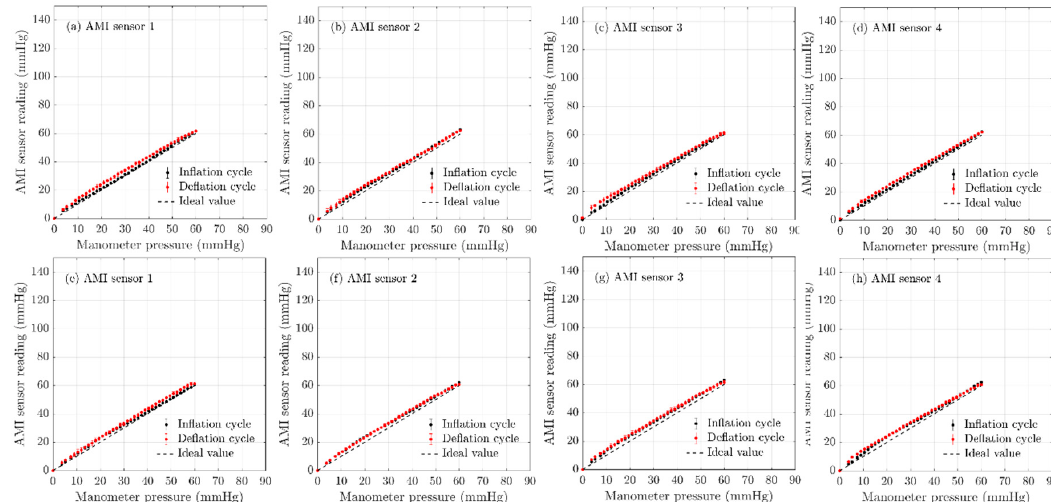
Figure 5. The results obtained using the bladder test: the validation of AMI air-pack sensor readings against the manometer reading. The error bars represent the 95% confidence interval. ( a – d ) represent